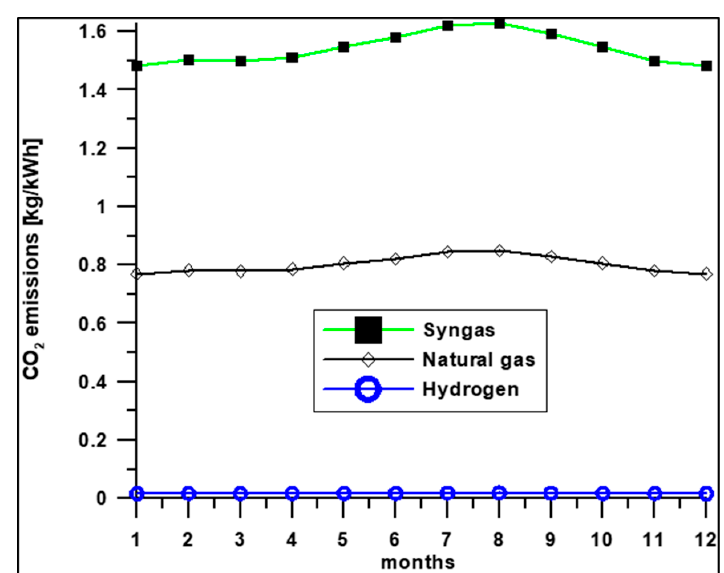
Figure 16. Heat transfer in cogeneration unit during year (night hours).